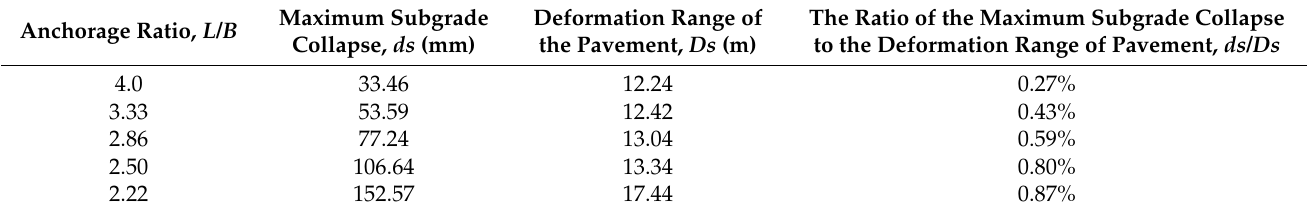
1%. The maximum subsidence with the anchorage ratios of L = 4.0 B , L = 3.33 B , L = 2.86 B , L = 2.50 B and L = 2.22 B at the surface are shown in Table 5. The maximum subgrade collapse of all of the groups is smaller than the specified value of ds / Ds of 1% in BS 8006. Table 5. Settlement of the subgrade surface with the various anchorage